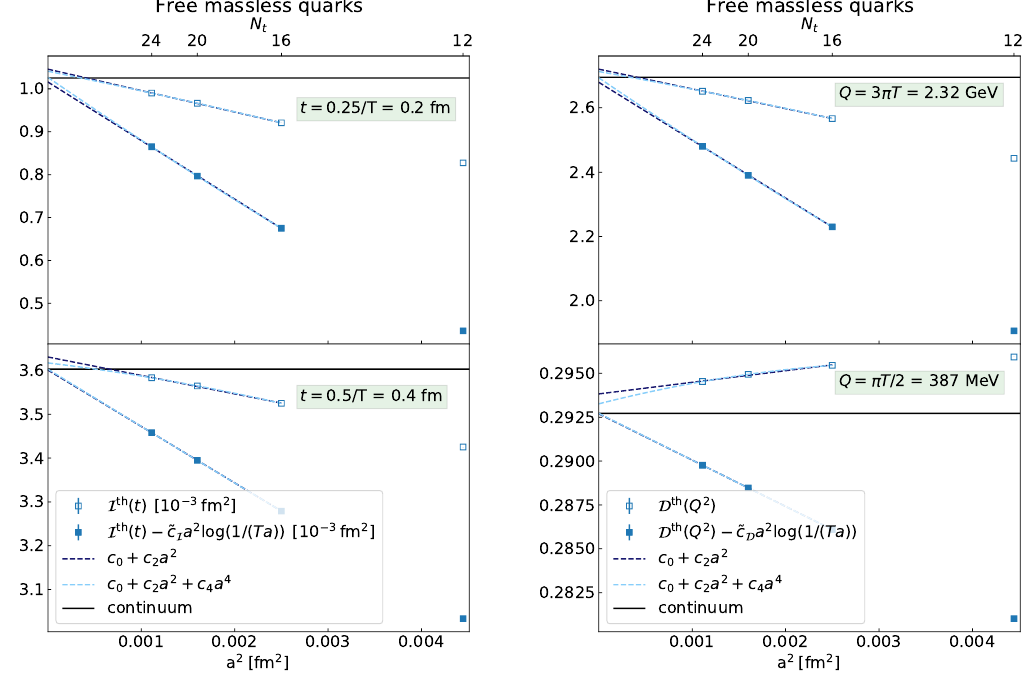
Figure 3 . Continuum limit of the thermal quantities I th ( t ) (left) and D th ( Q 2 ) (right). Four lattices are considered, with N t = 12 , 16 , 20 , 24 and whose temperature is fixed to 246.25 MeV. The coarsest lattice with N t = 12 is excluded from the fits. Polynomials of first and second degree in a 2 are used to fit the data. More accurate extrapolations are obtained by making use of the known coefficients ˜ c I (3.9) and ˜ c D (3.11) to subtract the O ( a 2 log(1 /a )) contribution from the lattice data. The relative differences between the continuum estimates shown in this figure and the correct continuum values are listed in table